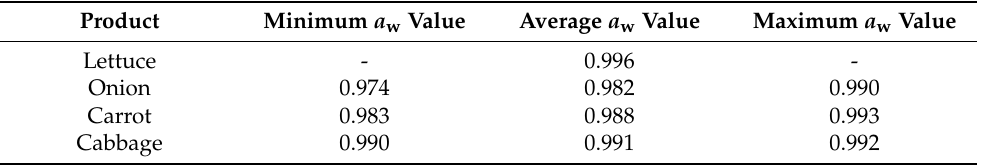
Table 1. Water activity intervals for each horticultural product